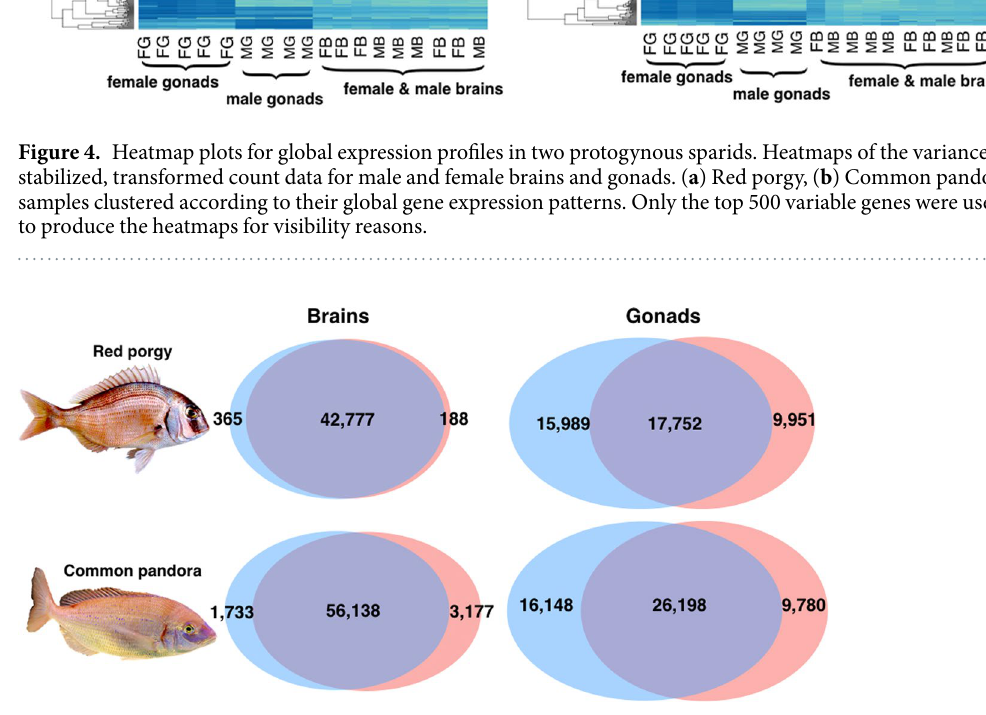
Figure 5. Comparative view of the number of genes differently expressed in brains and gonads of males and females of two protogynous sparids. Venn-like diagram showing the genes differentially expressed in brains and gonads of male and female red porgy and common pandora. Light-Blue: male-biased genes. Red: female-biased genes. Dark-Purple (intersection): un-biased